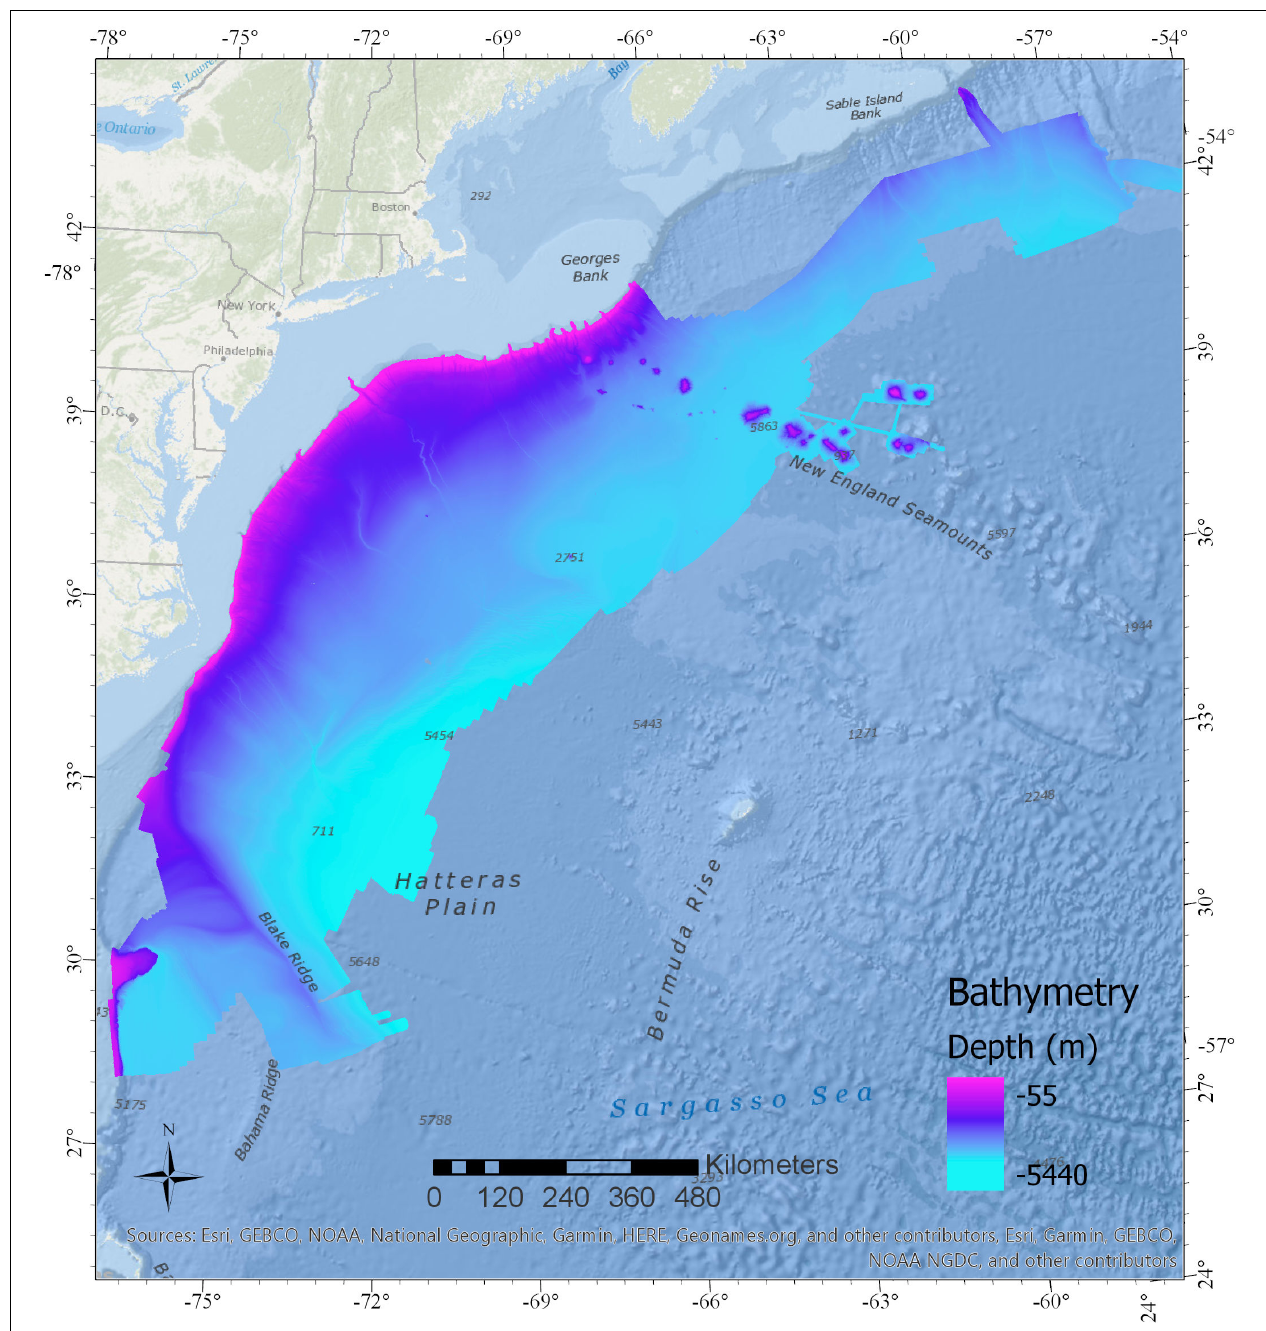
FIGURE 1 | Bathymetric synthesis terrain model grid of the U.S. Atlantic Margin study region used as the primary data source input into the study.